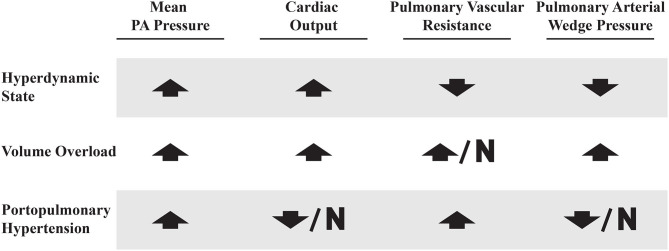
Right heart catheterization profiles in patients with elevated mean PA pressures. Up arrow, increased; Down arrow, decreased; N, normal.